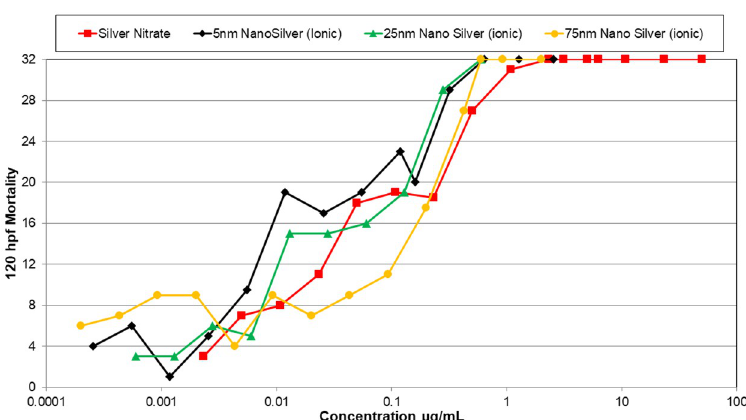
Fig 3. Mortality curves of zebrafish embryos exposed to different nanomaterials. 120 hpf mortality curves of zebrafish embryos exposed to different nanomaterials. Mortality curves consist of multiple tests. If the concentrations between tests of the same nanomaterial overlapped, the average mortality at the concentration was reported in the mortality curve. This figure shows the mortality curves of silver nanomaterials with the concentrations adjusted for the concentration of ionic silver in solution. (120 hpf (LC50) for the silver nanomaterials with adjusted concentrations are as followed: silver nitrate (0.08 μ g/mL), 5 nm nano silver (0.03 μ g/mL), 25 nm nano silver (0.04 μ g/mL), and 75 nm nano silver (0.16 μ